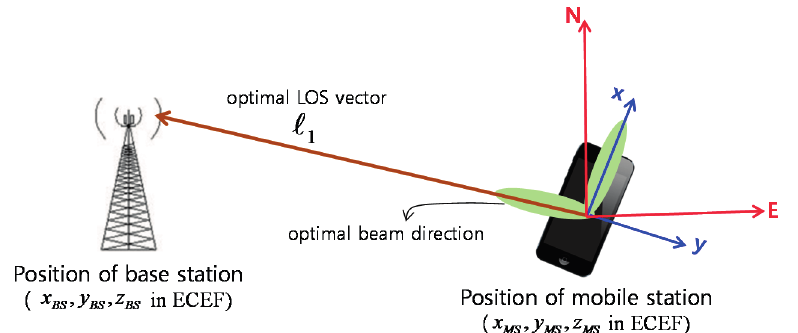
Figure 2. Coordinate frames of base station (BS) and MS for finding an optimal beam